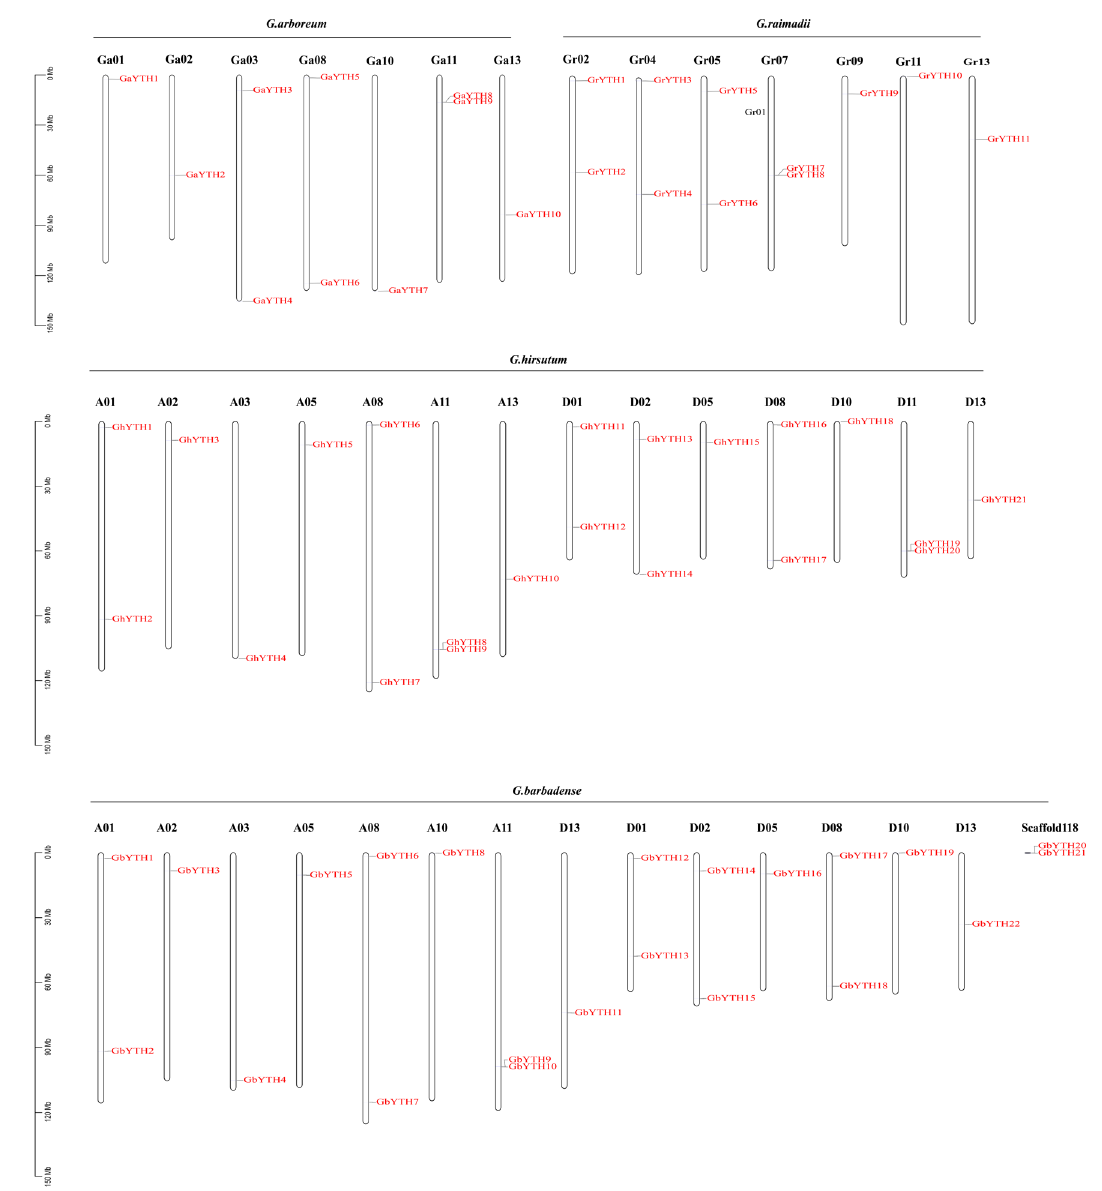
Figure 3. Distribution of the YTH genes on chromosomes of G. arboretum , G. raimondii , G. hirsutum , and G. barbadense .